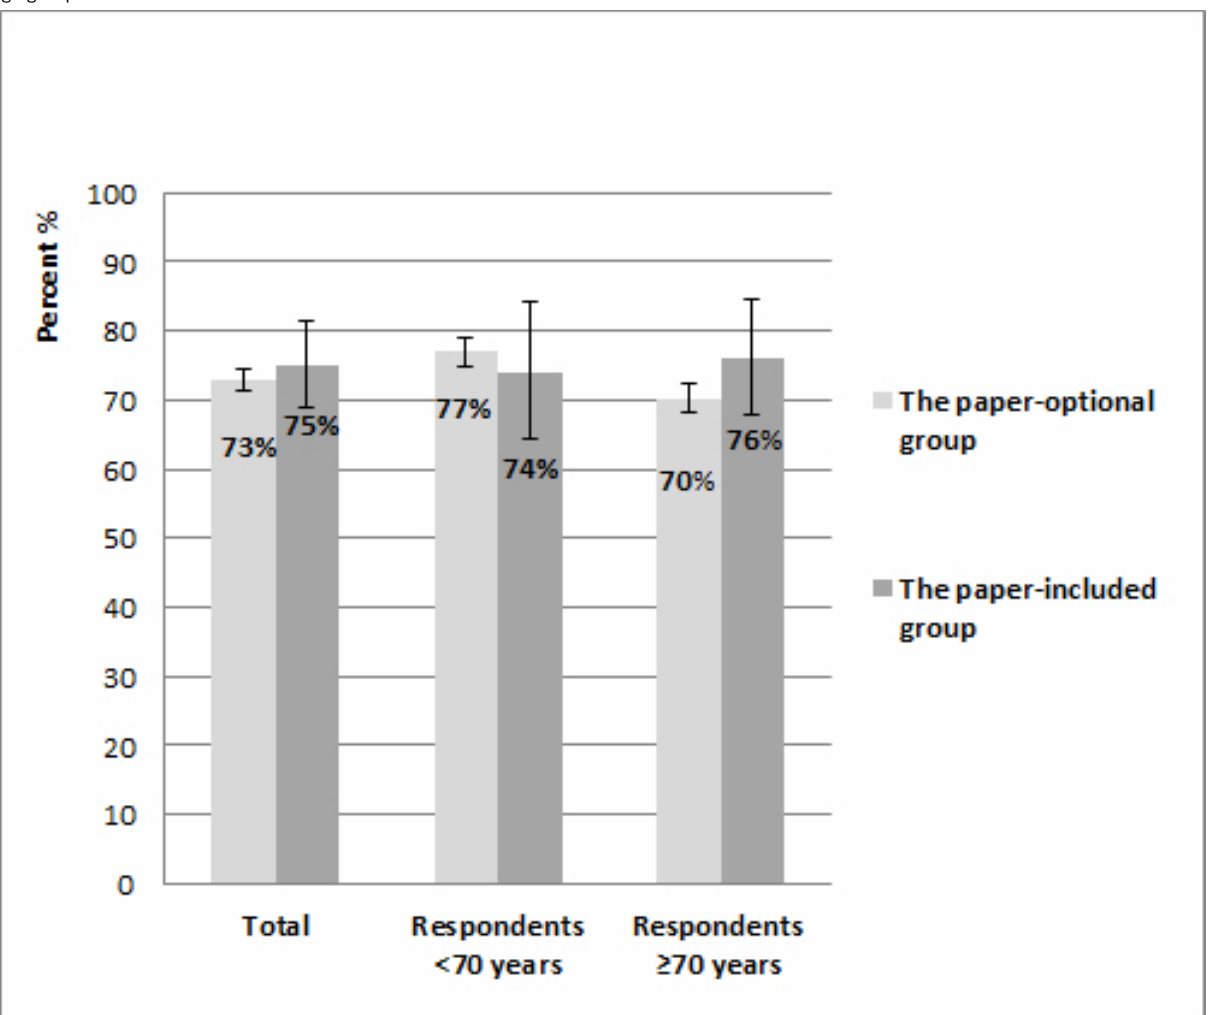
Figure 2. Overall response differences for the paper-optional (n=3406) and the paper-included (n=179) groups in a colorectal cancer population stratified by age